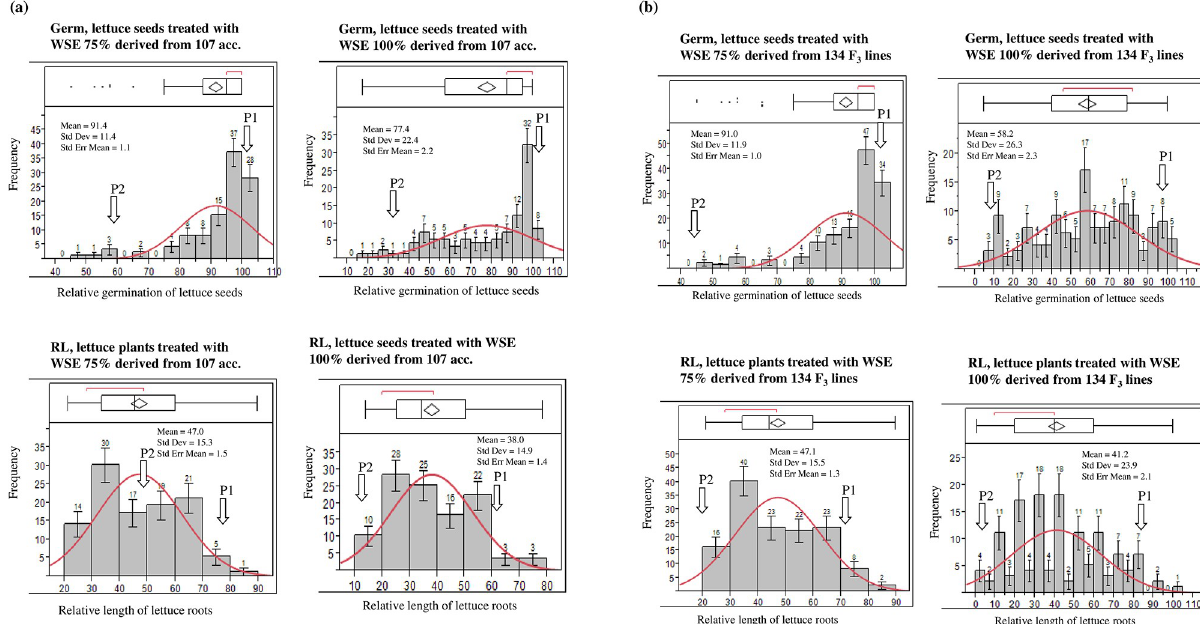
Fig 1. (a) Distribution of germination and root length of lettuce treated with water soluble extract (WSE) of 107 sorghum accessions (SDRS) seedlings used in 100% concentration. (b) Distribution of germination and root length of lettuce treated with water soluble extract (WSE) of 134 F 2 derived F 3 family lines. The red curve is the normal density curve. The top part is Quantile Box Plot (the Outlier Box Plot) and the disconnected points are potential outliers. A red bracket defines the shortest half of the data (the densest region). The results of the first, second, and third run of the outlier identification are displayed in each individual plot from left to right. P1/P2 represents Parent 1 (Tokibi) and Parent 2 (Phatsai), the arrow indicates its trait value where it falls. The term relative represents % germination or root length of the values recorded for control.